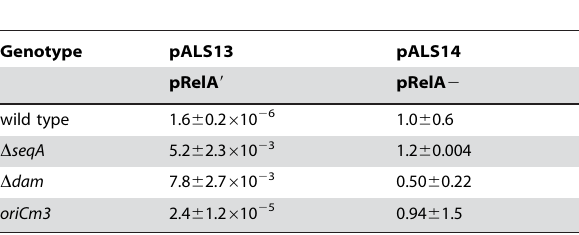
Table 1. Efficiency of plating with chronic stringent response